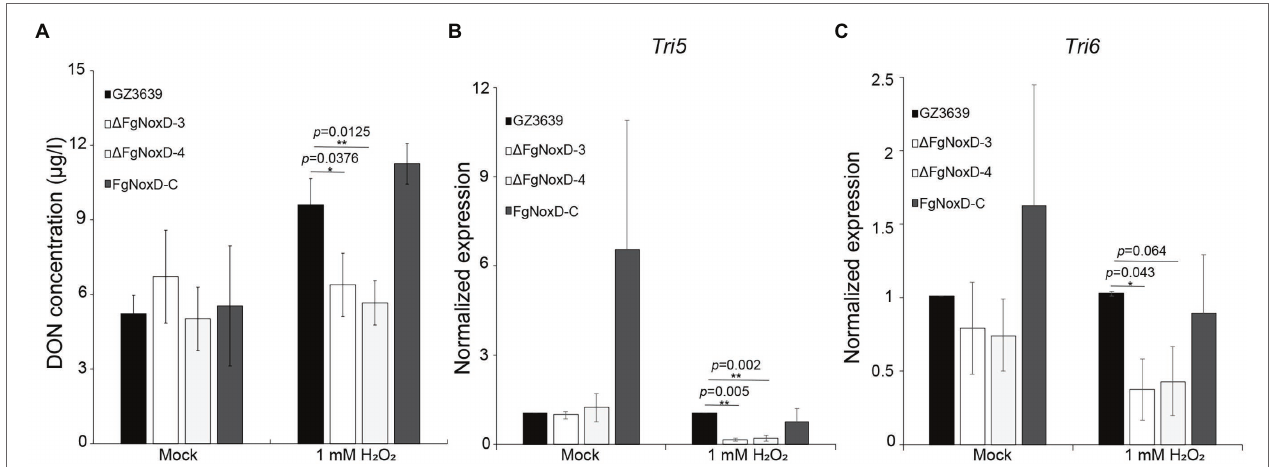
FIGURE 8 | Deoxynivalenol (DON) biosynthesis of GZ3639, Δ FgNoxD, and FgNoxD-C. (A) The DON concentration of F. graminearum strain. Supernatant of each culture was used to analyze DON concentration. (B,C) Relative expression levels of Tri5 and Tri6 . GZ3639, Δ FgNoxD and FgNoxD-C were cultivated in GYEP with or without (Mock) 1 mM H 2 O 2 for 5 days. The mycelia of F. graminearum strain was used to measure the transcript expression level. For DON concentration, bars denote SD from three repeated experiments. For qRT-PCR bars denote SE from three repeated experiments with three replications. Asterisks indicate value of p (* p < 0.05, ** p < 0.01) after comparison with t